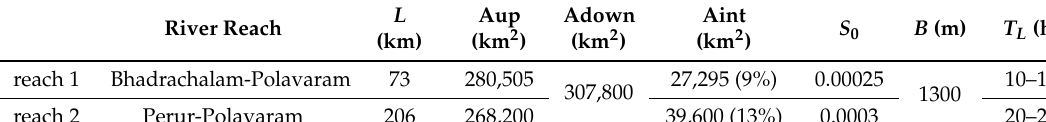
Table 1. Godavari River: main properties of the selected river reaches ( L , length; Aup and Adown, upstream and downstream drainage area; Aint, intermediate drainage area; S 0 , mean bed slope; B , mean section width; T L , mean wave travel time).